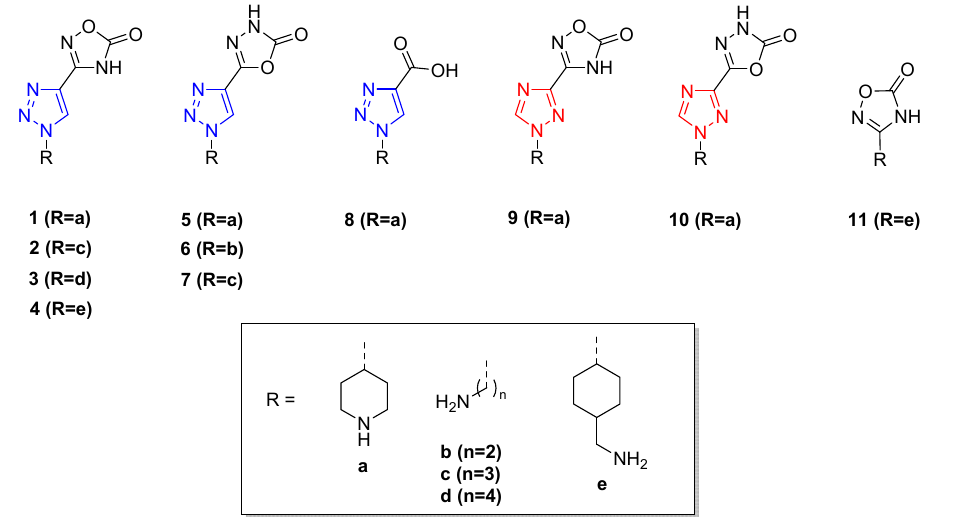
Scheme 1. Studied compounds for their antifibrinolytic activity.